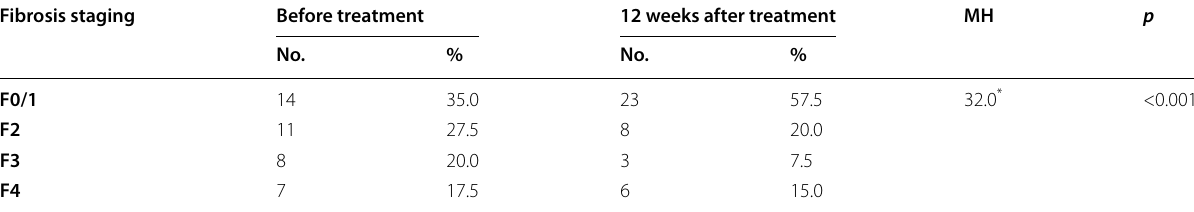
MH marginal homogeneity test, *significant